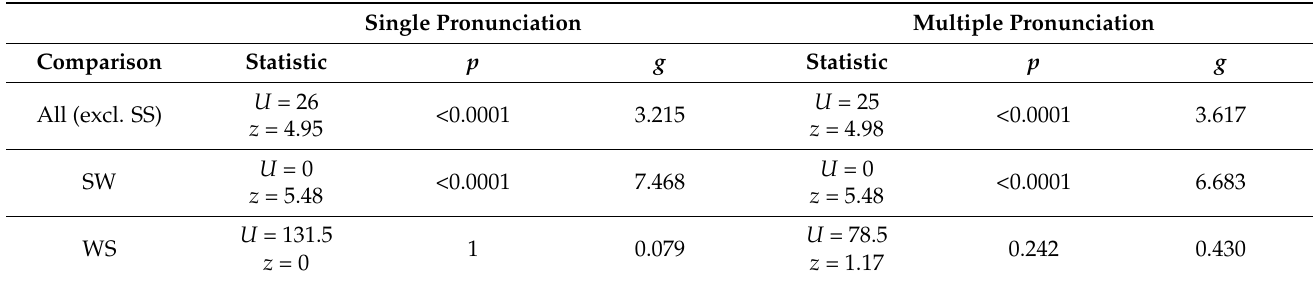
Figure 4. Percent agreement for automated classification with single- vs. multiple-pronunciation HMM-based forced alignment compared with auditory perceptual judgment, for words produced with correct and incorrect lexical stress. CAS = childhood apraxia of speech, TD = typically developing, SS = strong–strong stress, SW = strong–weak stress, and WS = weak–strong stress. Table 5. The lexical stress tool’s accuracy against human judgement for children with childhood apraxia of speech (CAS), for words perceived by raters as having correct versus incorrect stress